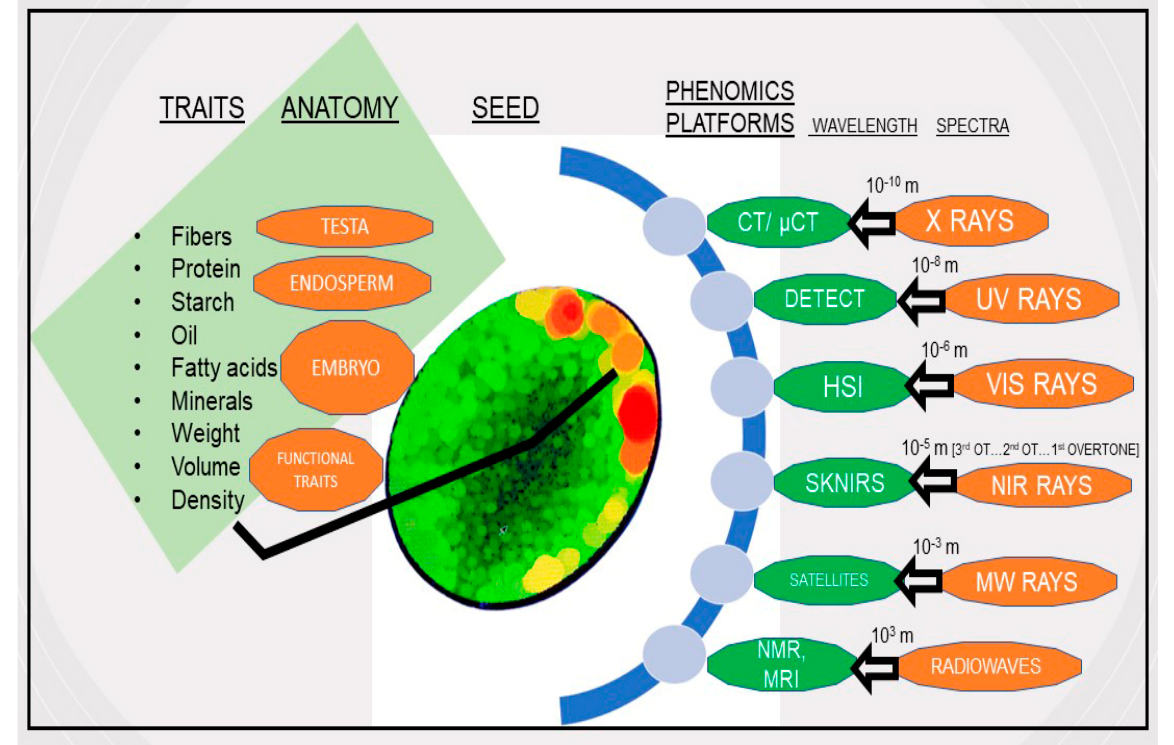
Figure 1. Anatomy of seeds, whole spectra modalities across wavelengths, and specific applications. NIR: near infrared; UV: ultraviolet; VIS: visible; MW: microwave; µ CT: micro-computed tomography; HSI: hyperspectral imaging; SKNIRS: single kernel near infrared spectroscopy; OT: overtone; NMR: nuclear magnetic resonance; MRI: magnetic resonance imaging. Note: Some whole spectra modalities not included in the review are radiowaves and microwaves.